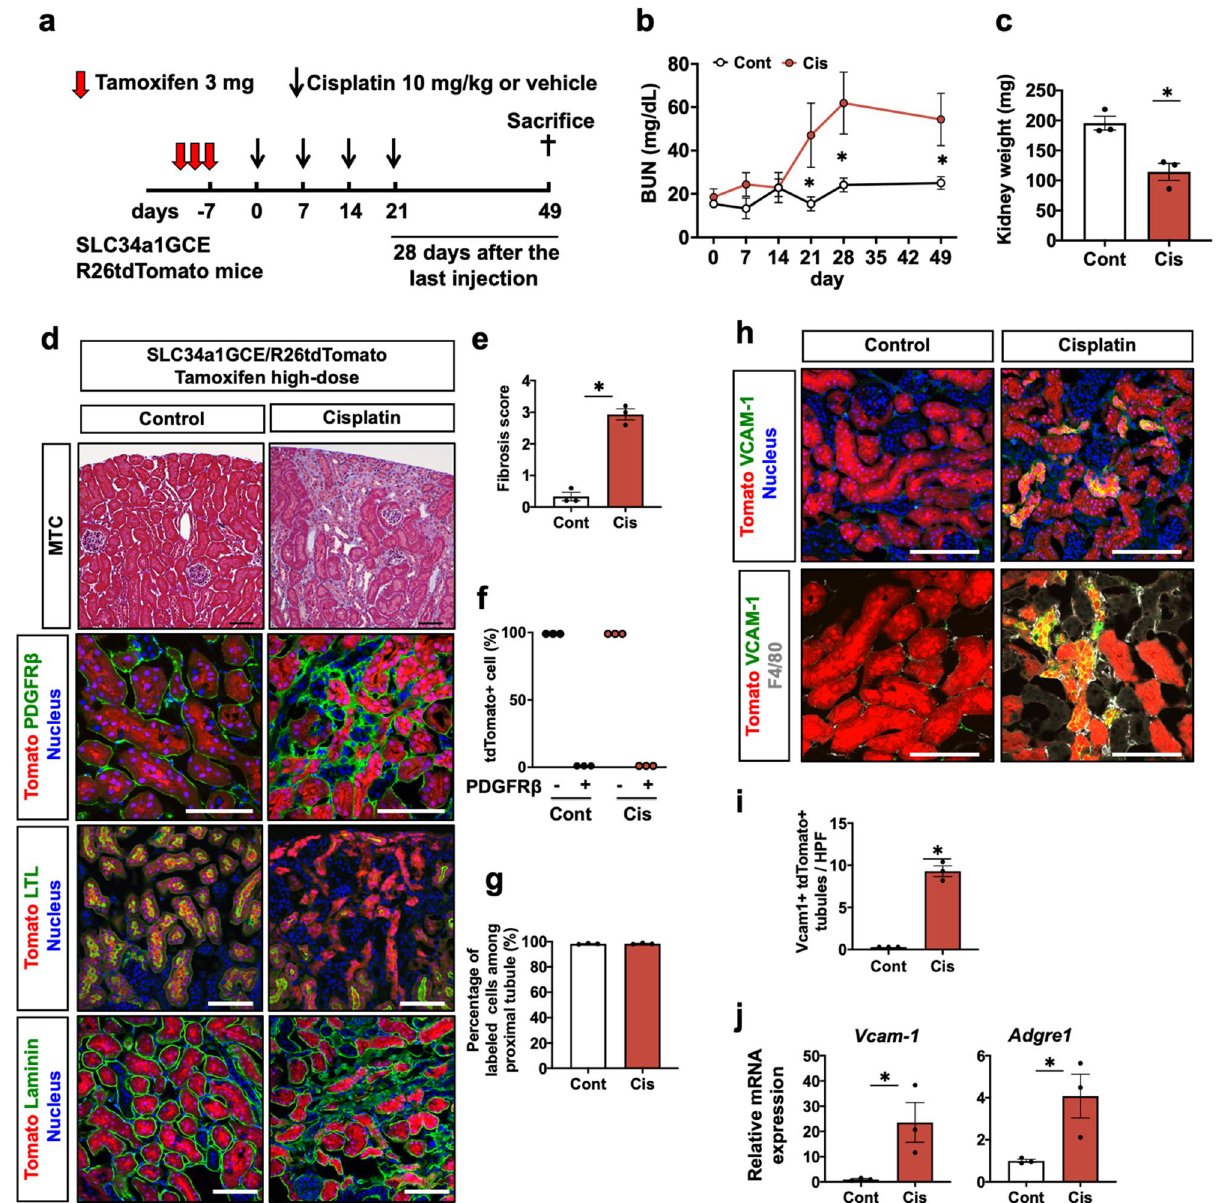
R26tdTomato mice after labeling of proximal tubular epithelial cells by multiple injections of high-dose tamoxifen. The kidneys were assessed at a later phase, 28 days after the last injection. ( b ) Chages in BUN level during and after repeated administrations of cisplatin. ( c ) The average kidney weight in the cisplatin and control groups. ( d ) Histological analysis of the kidneys in the cisplatin and control groups. Masson’s trichrome and immunostaining of PDGFRβ, LTL, and laminin. ( e ) Quantification of the fibrosis score. ( f ) Quantification of PDGFRβ positivity in the tdTomato + cells. tdTomato + tubules never merged with PDGFRβ. ( g ) Quantification of labeled cells. Labeled cells were not diluted in the cisplatin model. ( h ) Immunostaining of vcam-1 and F4/80. ( i ) Quantification of vcam-1 + tdTomato + tubules. ( j ) Quantitative PCR of whole kidneys for vcam-1 and adgre1 genes. Data are the average ± SE. * P < 0.05. Scale bar = 100 μm in MTC and 50 μm in